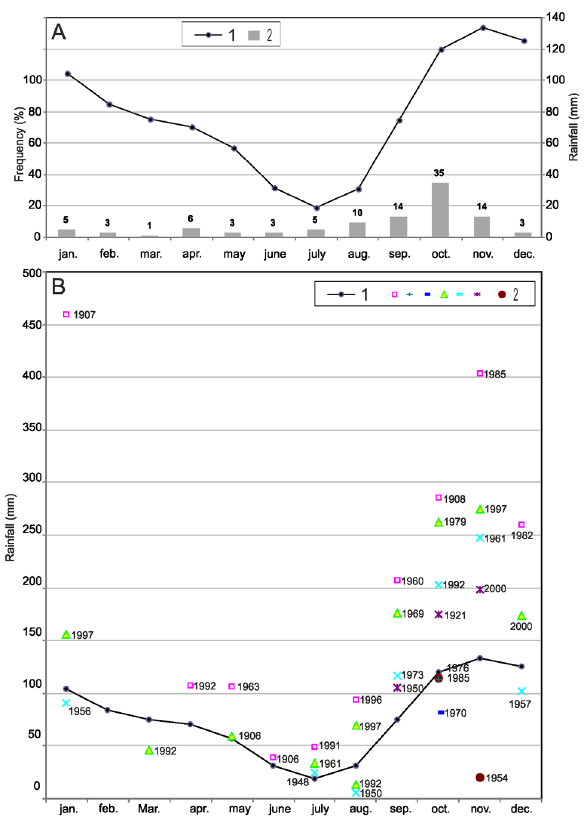
Figure 10. Flood events and monthly rainfall. A) relationship be- tween the the monthly average rainfall curve since 1906 (1) and fre- quency of the events (2); B) correlation between the monthly rainfall observed for all events and the monthly average rainfall curve; 1) monthly average rainfall curve; 2) cumulative monthly rainfall for each event.